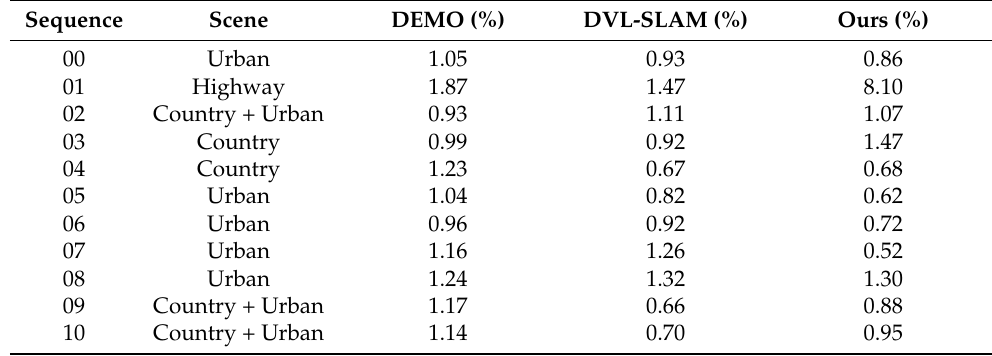
Table 3. The average translation error of different algorithms on the KITTI Visual Odometry